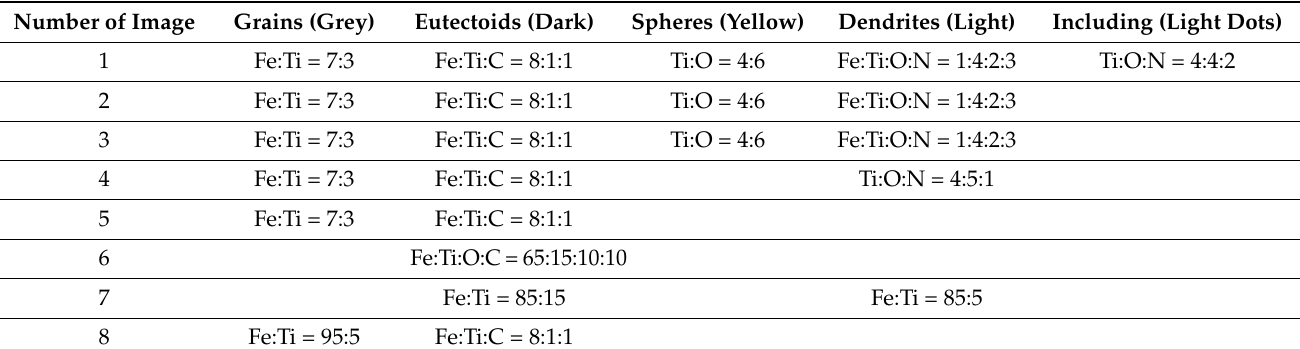
Table 1. Structural components of graded structures from Figure 2.